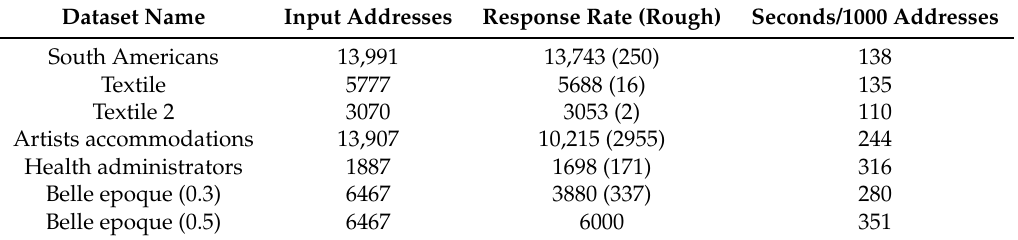
Figure 12. Illustrations of all the historical textual address data sets that were geocoded. Result size is proportional to spatial precision. Table 1. For all textual address historical data sets, how many addresses were geocoded and how long it